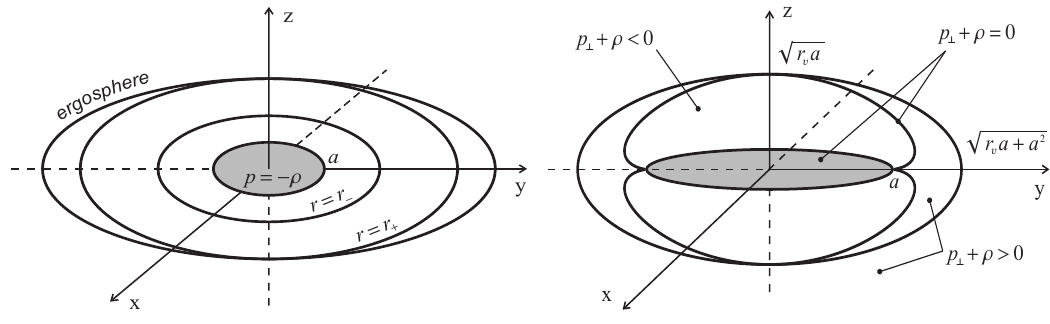
Figure 1. ( Left : Horizons), ergosphere and the de Sitter vacuum disk for the first type of interior. ( Right ): Vacuum S -surface p ⊥ + ρ = 0 for the second type of